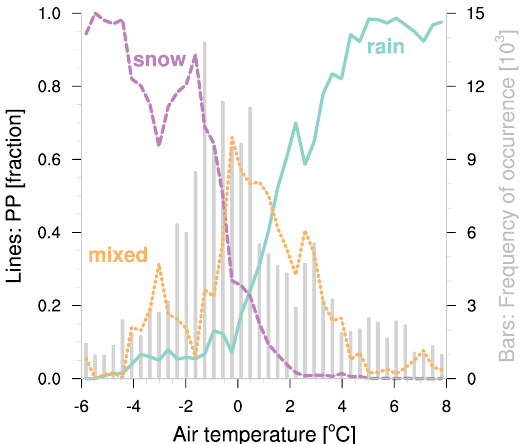
Figure 10. Lines show PP fraction for rain (solid, cyan), mixed phase (dotted, orange), and snow (purple, dashed) from Ocean- RAIN RSM (165632min) determined with the manual PP estima- tion against temperature. Gray bars represent the temperature fre- quency of occurrence (in 10 3 ).